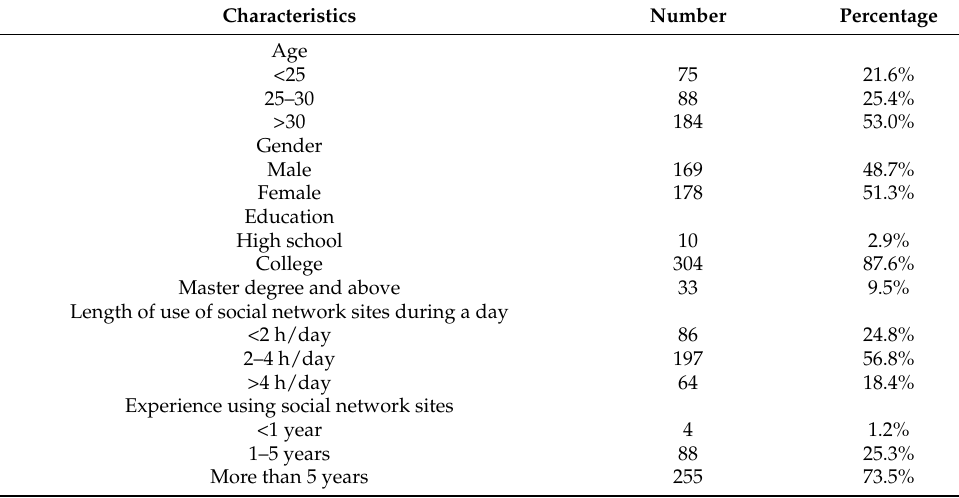
Table 1. Demographic information of sample